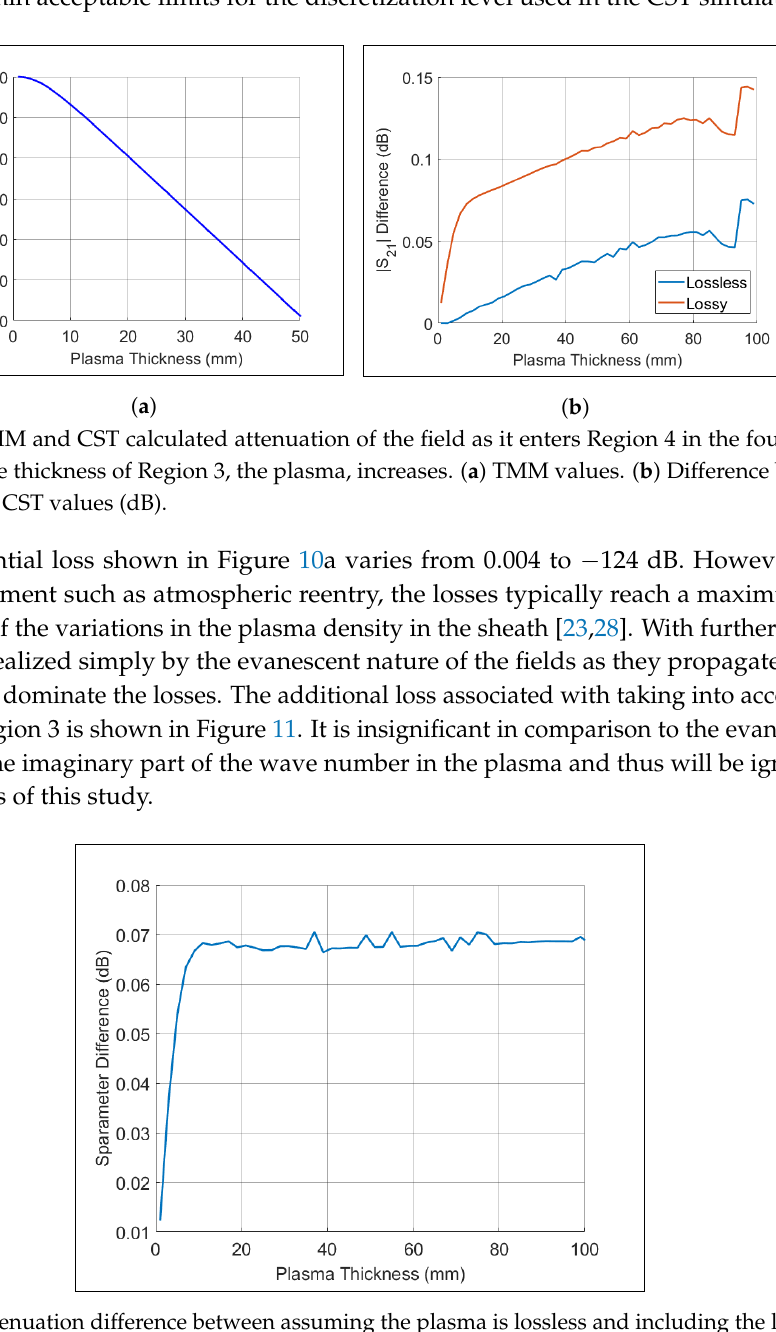
Figure 11. Attenuation difference between assuming the plasma is lossless and including the loss term Im [ (cid:101) r ]